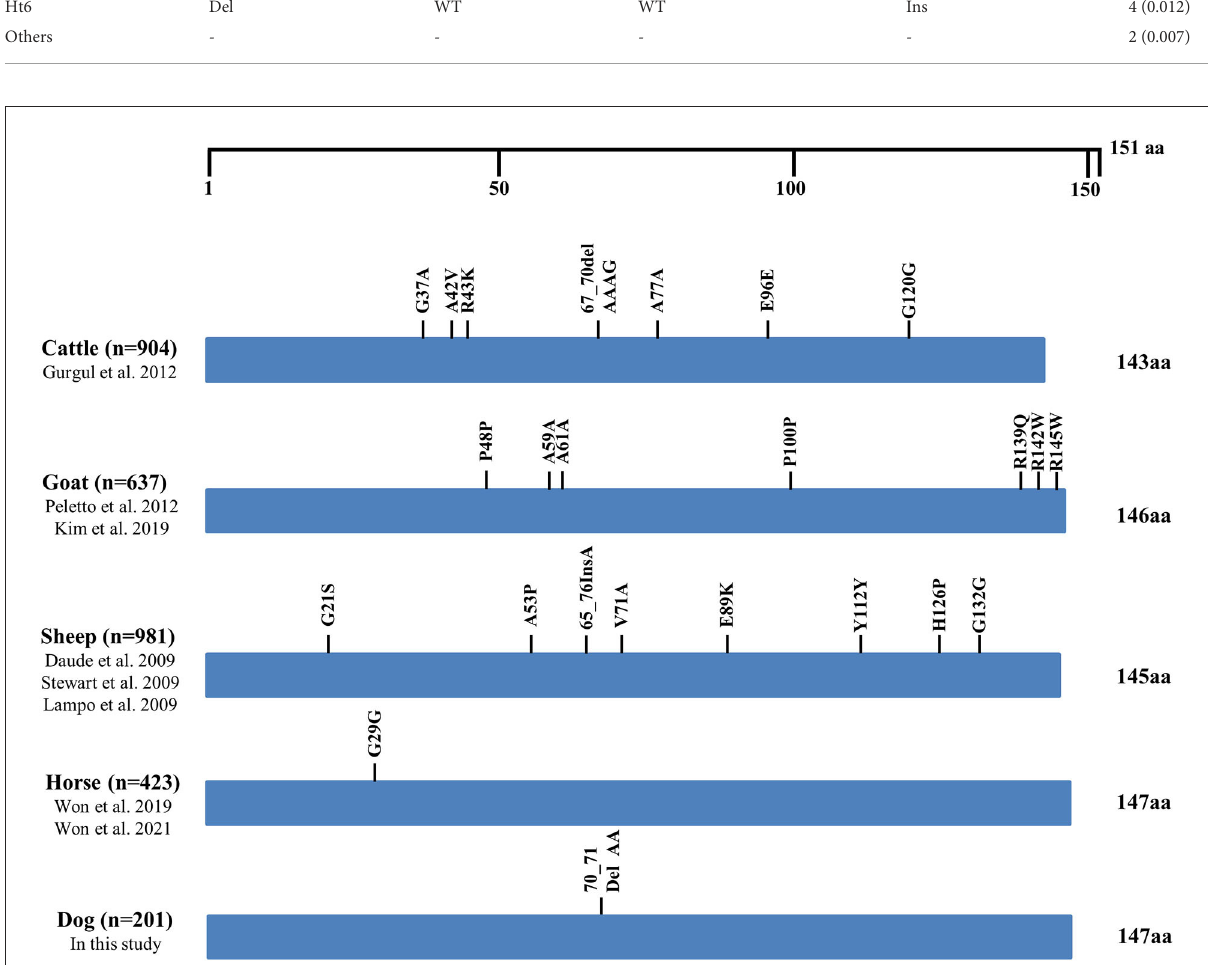
FIGURE2 Distribution of genetic polymorphisms in the open reading frame (ORF) of the SPRN gene in several species. The figure indicates reported genetic polymorphisms of the SPRN gene in humans, cattle, goats, sheep, horses, and dogs. The edged horizontal bar indicates the length of the amino acids in the SPRN